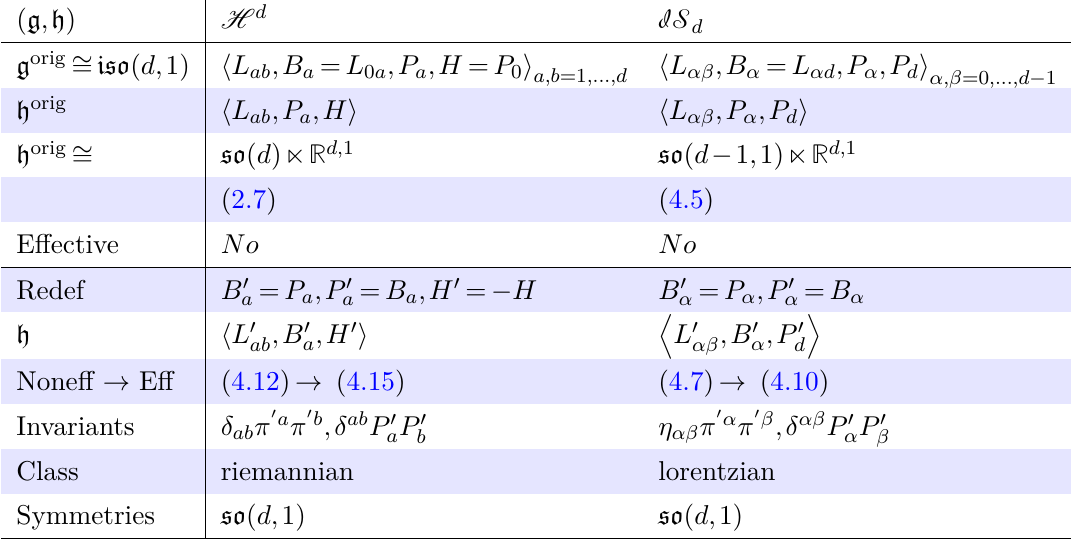
Table 2 . Overview of the d -dimensional homogeneous spaces of the Poincaré group that descend from Ti = AdSC and Spi d +1 d +1 d +1